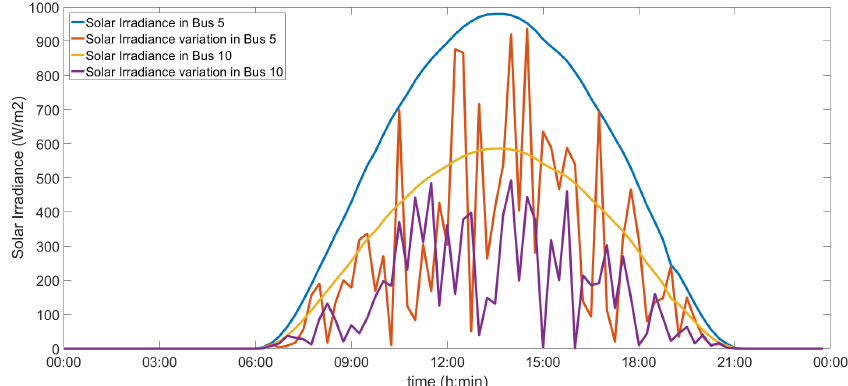
Figure 10. Daily Solar Irradiance